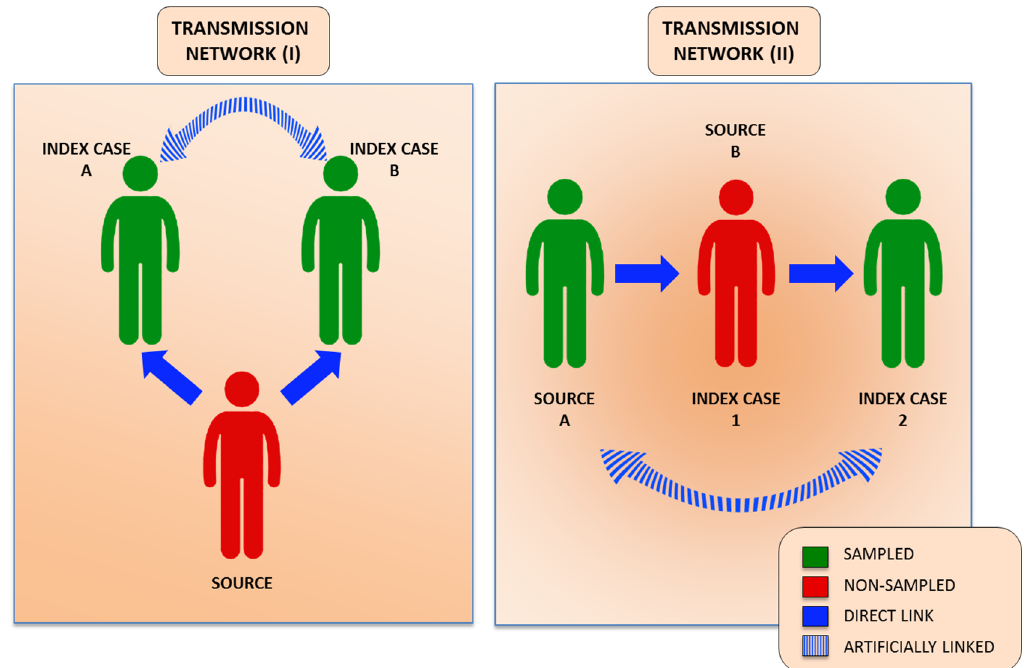
Figure 5. HCV transmission networks. Two transmission networks are depicted. The limitations of HCV molecular studies are depicted when not all individuals belonging to the transmission network are included. Artificially linked cases can be observed when not all members of the transmission network are